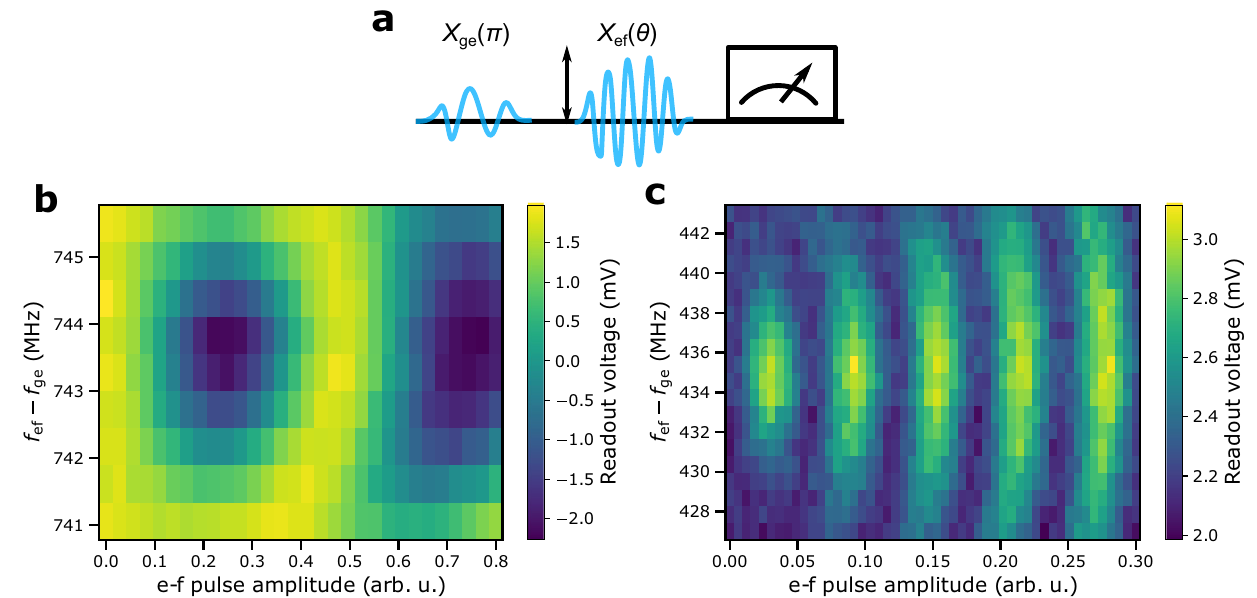
Fig. 6 | Estimation of qubit anharmonicity using Rabi oscillations. of the ef-pulse and the frequency difference f ef − f ge in an ef-Rabi experiment con- a Measurement sequence of anef-Rabi experiment. In the experiment, the qubitis ducted for qubits A ( b ) and B ( c ).The resulting observed Rabioscillations between fi rstprepared inthe excitedstate witha π -pulseatthefrequency f the fi rst and the second excited states of the unimon com fi rm that the anharmo- ge matching with nicities α ofqubits A and Bare approximately744MHz and 434 MHz, respectively, the qubit frequency f 01 followed by another pulse with a fi xed duration but a as measured using a two-tone qubit spectroscopy such as that shown in Fig. 2c. varyingfrequency f ef andavaryingamplitude.Afterapplyingthepulses,theoutput readoutvoltageismeasured.Outputreadoutvoltageasafunctionoftheamplitude